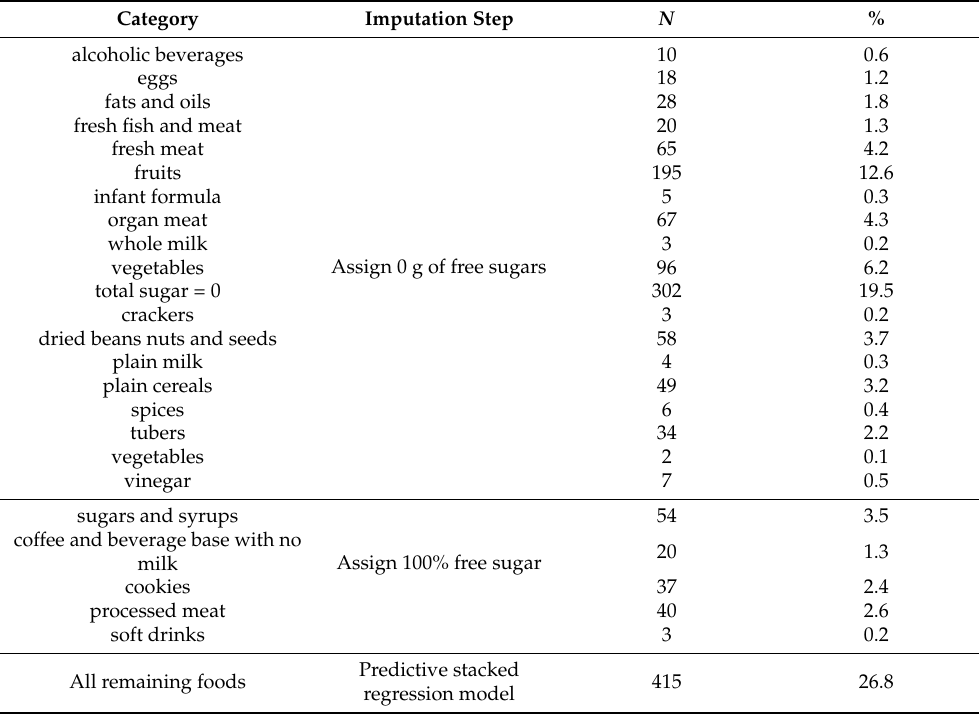
Table 2. Number of foods imputed in each